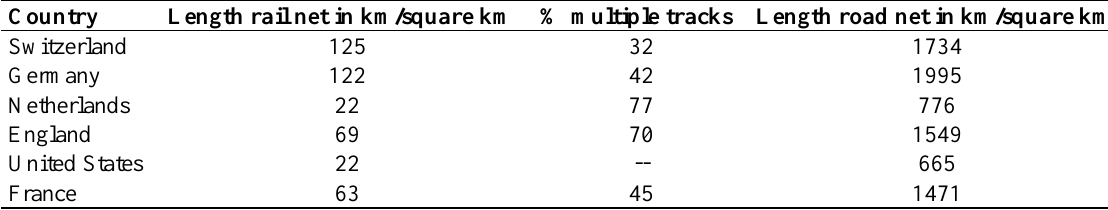
Table 7b. Size of the infrastructure networks II (1988)